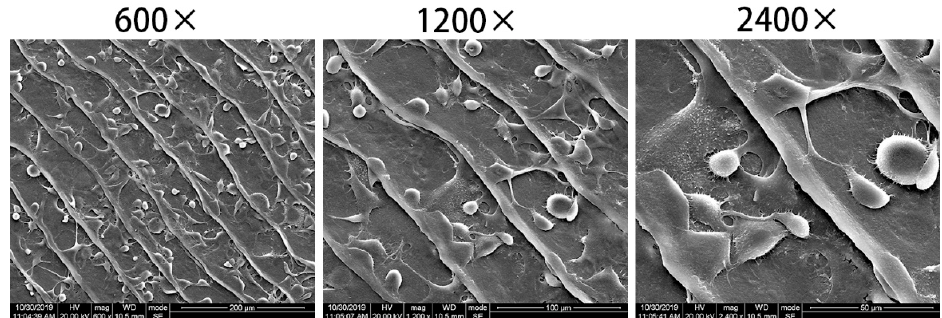
Figure 13. BMSCs adhered to the surface of fish scale collagen lamellar matrix after 3 h of cultiva- tion.